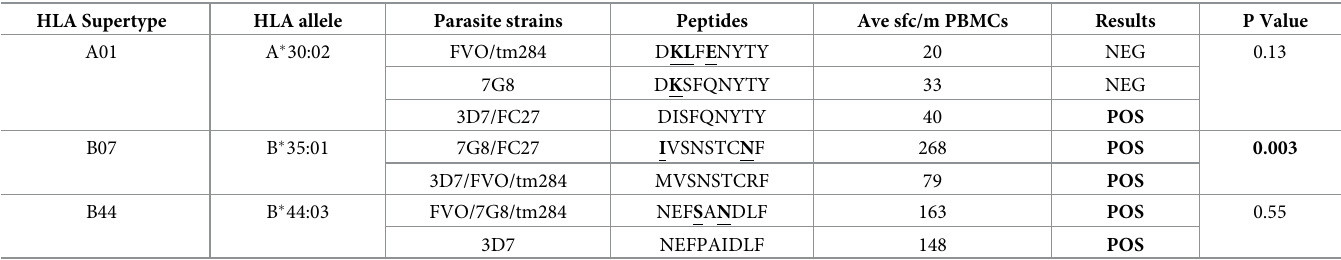
Table 3. Outcome of subject v03 PBMC stimulation with allelic peptide sets.